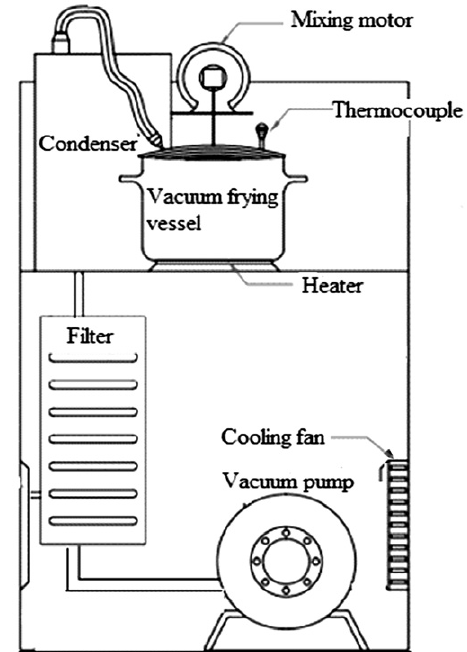
Fig. 1. Developed vacuum frying